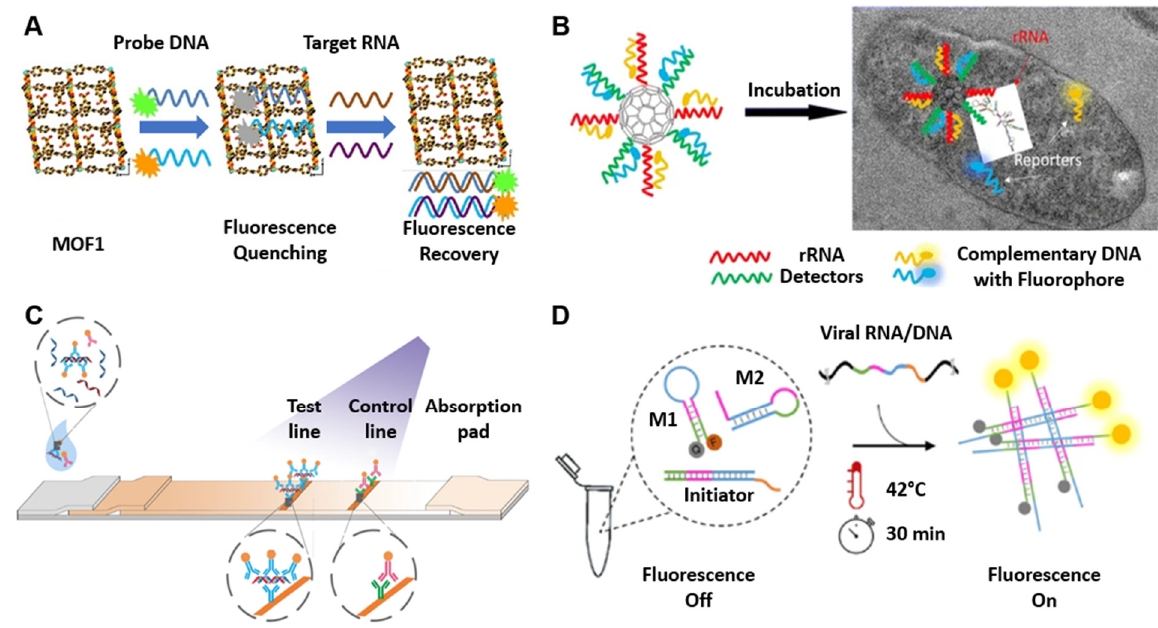
Figure 2. Structure-recognition biosensors. ( A ) Schematic of the 3D Cu-based metal–organic frame- works (MOF) interacting with two different fluorophore-labeled DNA probes, which can be used as effective sensing platforms for simultaneous detection of Dengue and Zika virus RNA sequences. The MOF can interact with two fluorophore-labeled DNA probes and quench the fluorescence. In the presence of Dengue virus and Zika virus RNA sequences, the DNA probes form a double-stranded DNA–RNA structure that results in fluorescence recovery. Adapted from [31] with copyright permissions from the publisher. Copyright © 2022, Elsevier. ( B ) Schematic design for the C60-rRNA detector–reporter complex, which enables bacterium detection at a specific excitation frequency. The C60-rRNA detector–reporter complex can enter the microbial cell, and when the rRNA detector hybridizes with the bacterial rRNA, the fluorophore-labeled complementary DNA is released and emits a fluorescence signal. Adapted from [32]. Copyright © The Author(s) 2017. ( C ) Schematic of hy- brid capture fluorescence immunoassay (HC-FIA). The amplification-free nucleic acid immunoassay employs DNA probes that are designed to bind to the conserved regions of the SARS-CoV-2 genome and a fluorescent-nanoparticle-labeled monoclonal antibody that binds to double-stranded DNA–RNA hybrids. Adapted from [37] with copyright permissions from the publisher. Copyright © 2022, Springer Nature. ( D ) Schematic of non-enzymatic isothermal strand displacement and amplification (NISDA) assay for rapid detection of SARS-CoV-2 RNA. The viral RNA/DNA displaces the short DNA template of the initiator. The released DNA template initiates the cascade unfolding of two DNA molecular beacon structures (M1 and M2), resulting in a substantial increase in the fluorescence intensity of M1. Adapted from [46]. Copyright © The Author(s)